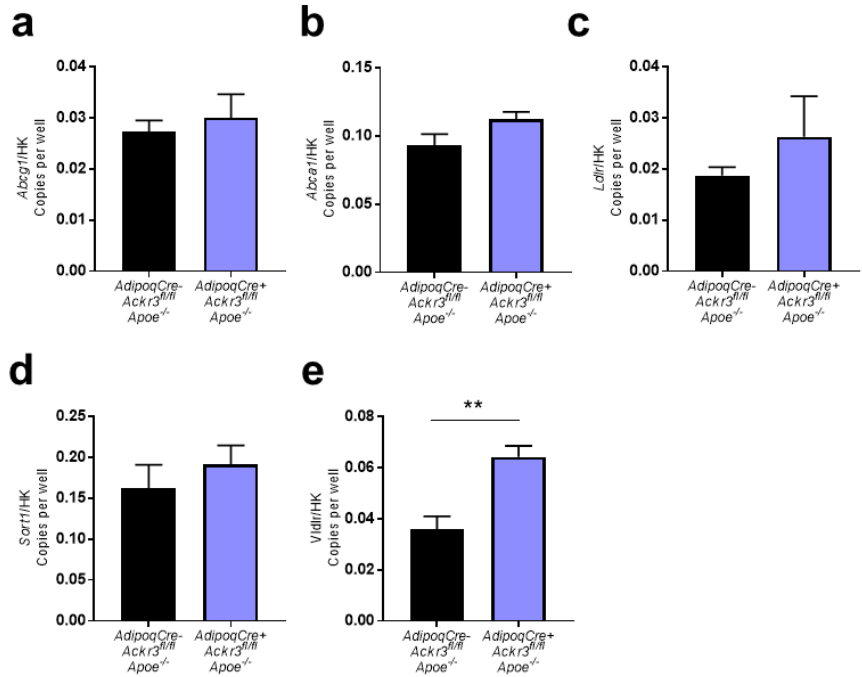
Figure 2. Expression of lipid receptors in wAT samples. a – e . Relative gene expression of Abcg1 ( a ), Abca1 ( b ), Ldlr ( c ), Sort1 ( d ), and Vldlr ( e ) to housekeeping genes ( Gapdh or 18S ) analyzed on Droplet Digital PCR (ddPCR) (all n = 4–7). ** p < 0.01.